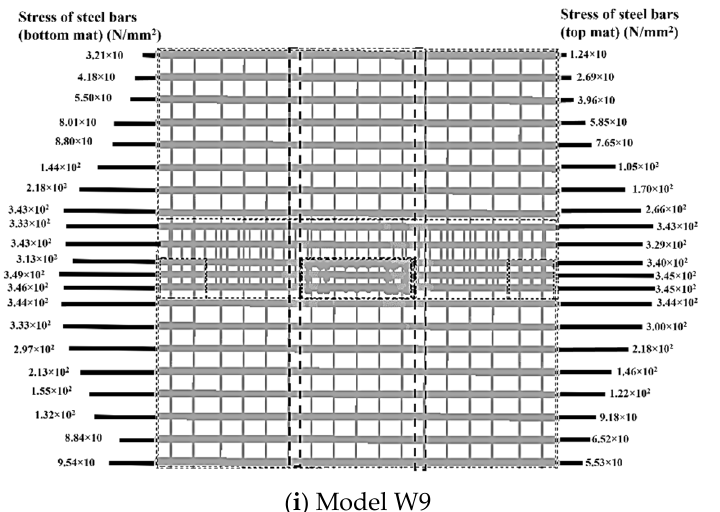
Figure 24. Stress and yield conditions for slab width models.